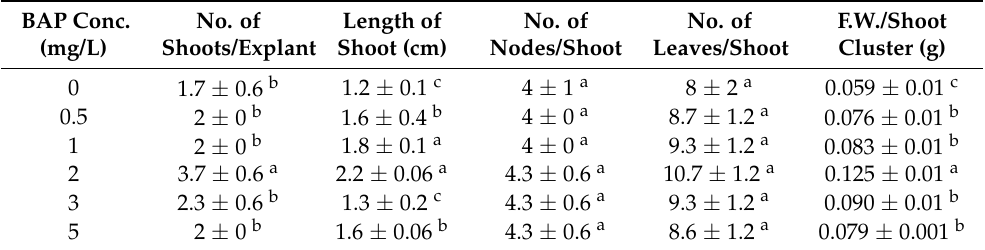
Table 1. Effect of different BAP concentrations in MS medium on in vitro shoot multiplication and growth of paulownia for one